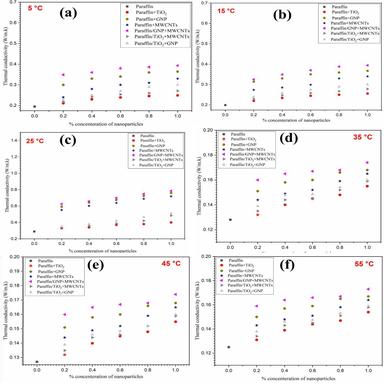
Influence of nanofillers concentration on thermal conductivity at various temperatures.